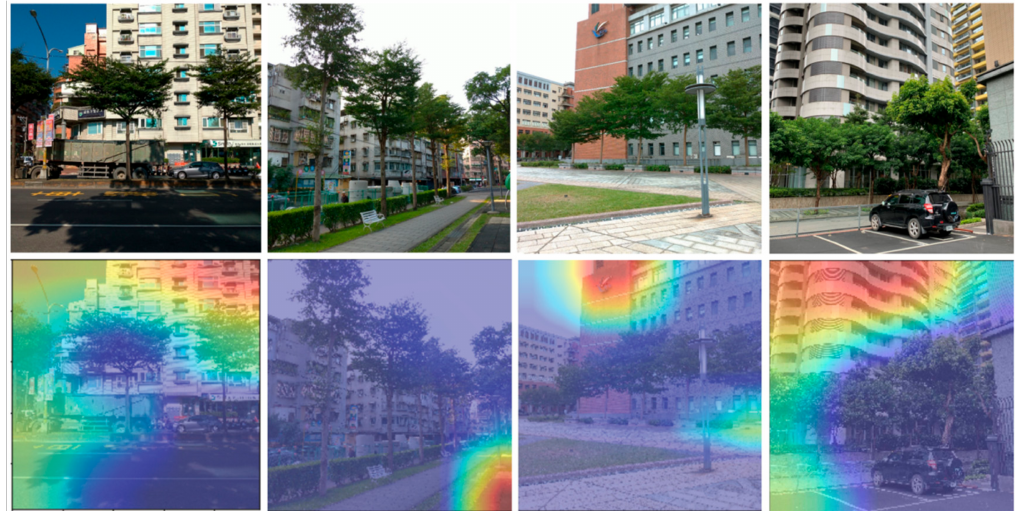
Figure 1. Grad-CAM visualizations. The top row is the original images in our tree species dataset. The bottom row is the Grad-CAM visualizations of our previous trained model. The heat maps localize class-discriminative regions, and red regions correspond to high score for class.